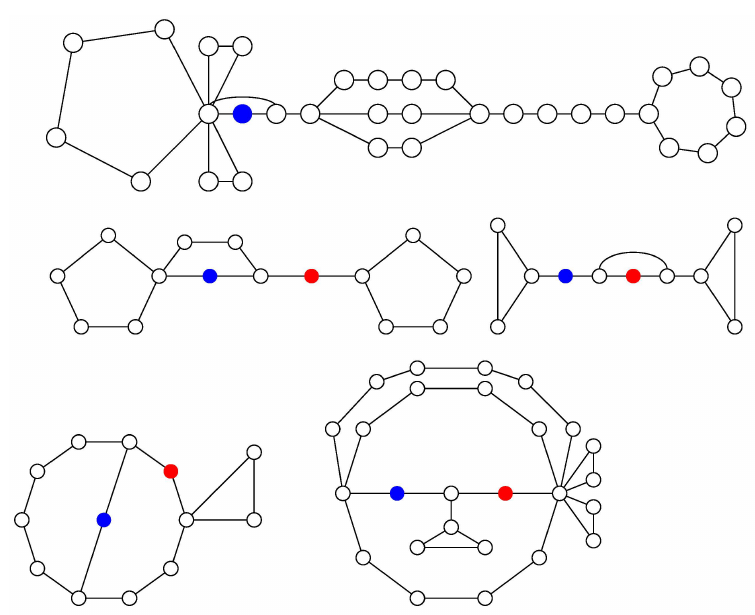
Figure 3. There are some graphs with F − ( G ) = 1. In each graph, the blue vertex represents one stalling set and in the last four graphs the red vertex represents another stalling